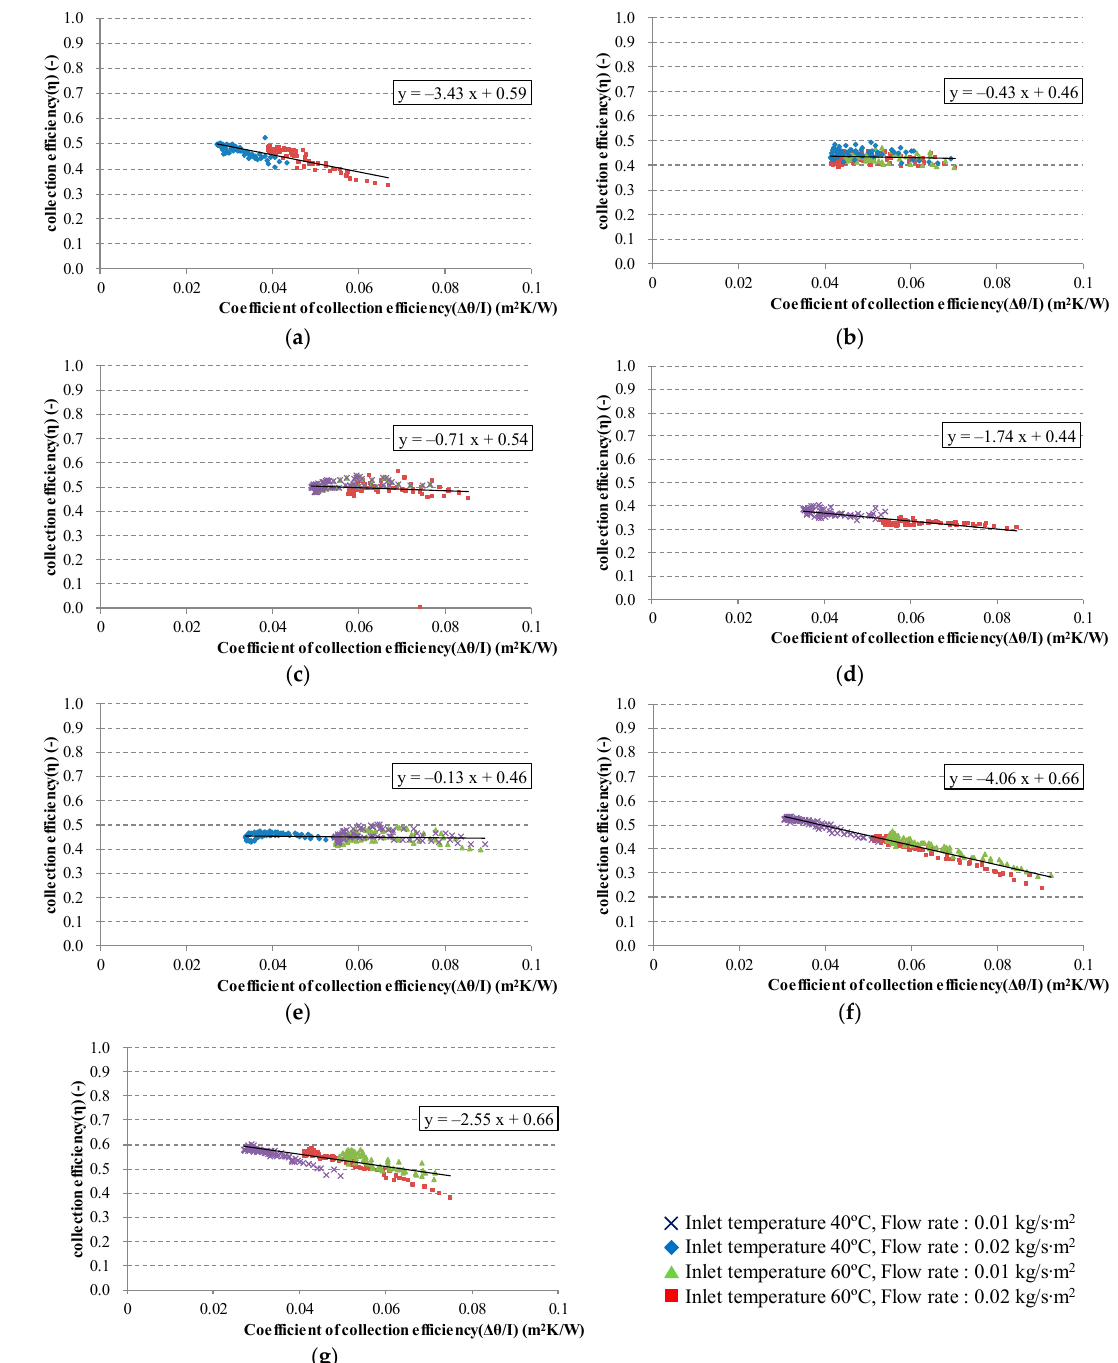
Figure 5. Comparison of the solar collection efficiency (base case and case 1).